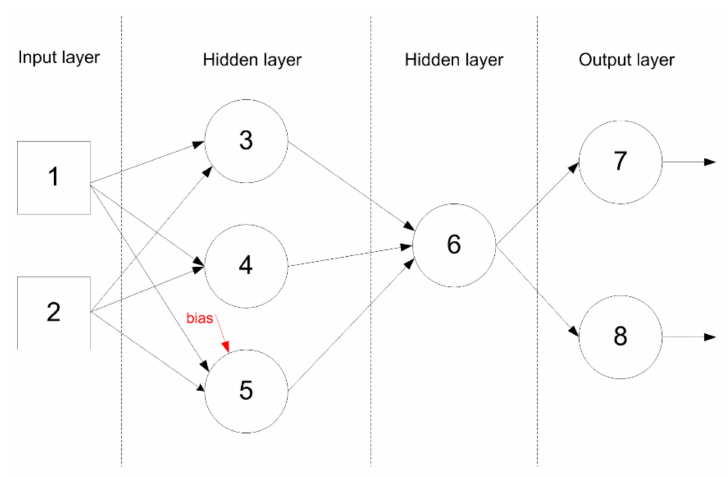
Figure 4. Structure of multilayer perceptron